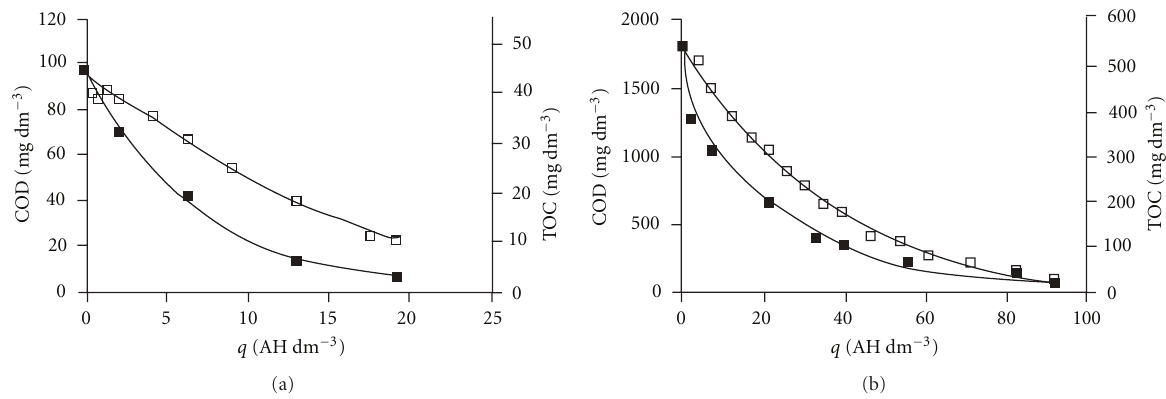
Figure 3: Changes in the COD ( (cid:2) ) and in the TOC ( (cid:3) ) with the current charge passed during electrolyses of EBT-polluted synthetic wastes. Operation conditions: current density, 300 A · m − 2 ; T = 25 ◦ C. Waste composition: sodium sulfate Na 2 SO 4 , 5000 mg · dm − 3 ; natural pH. COD 0 : (a) 100 and (b) 1813mg · dm − 3 O 2 [20].